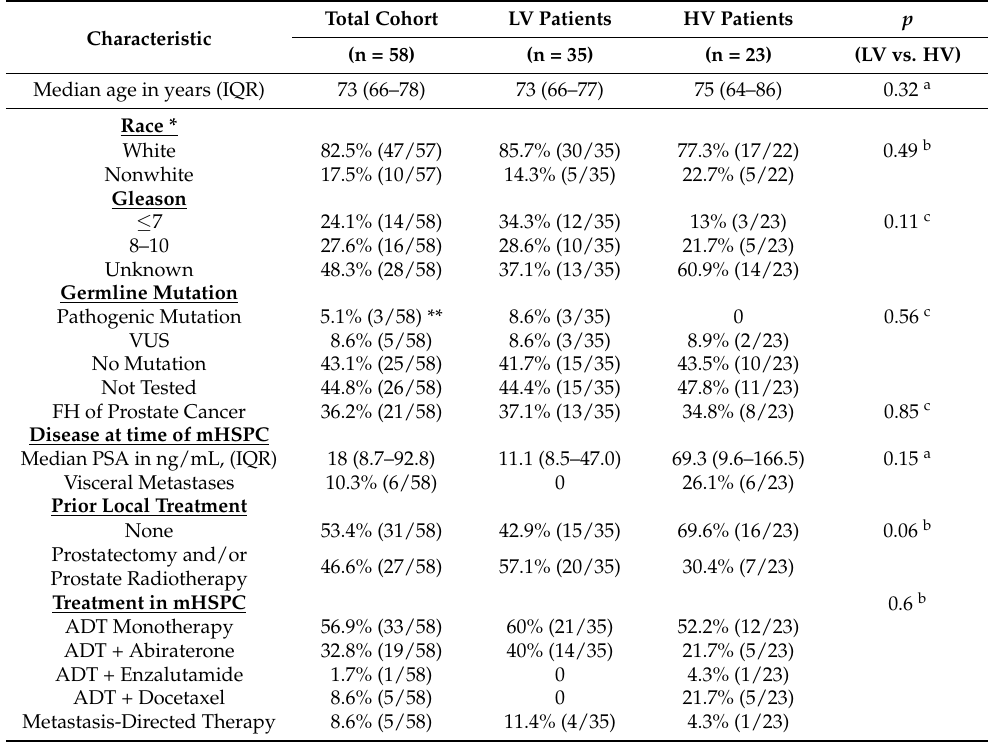
Table 1. Demographic and clinical characteristics of the MiCoPilot